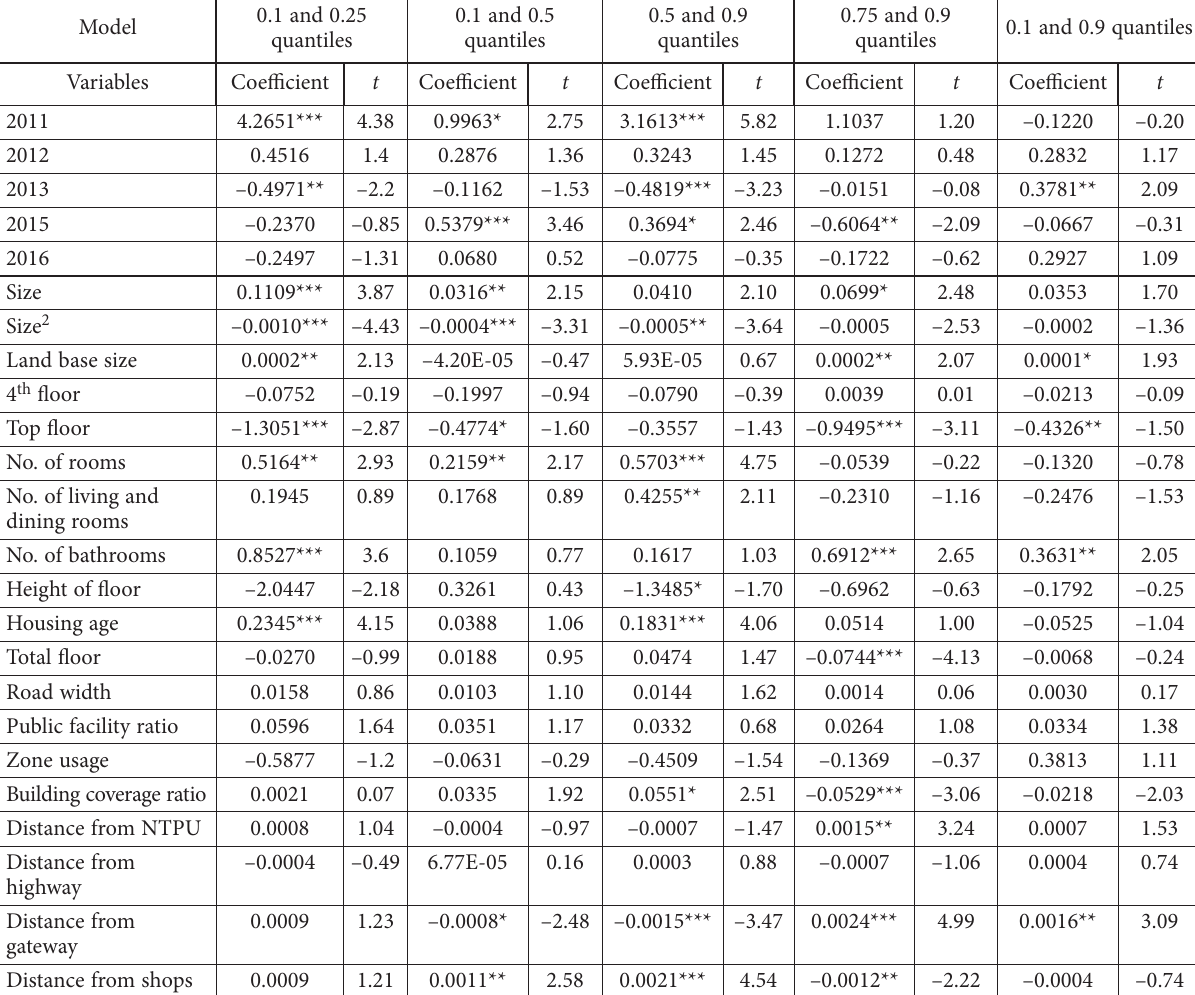
Table 6. Housing price-per-ping model – coefficient difference test results for different